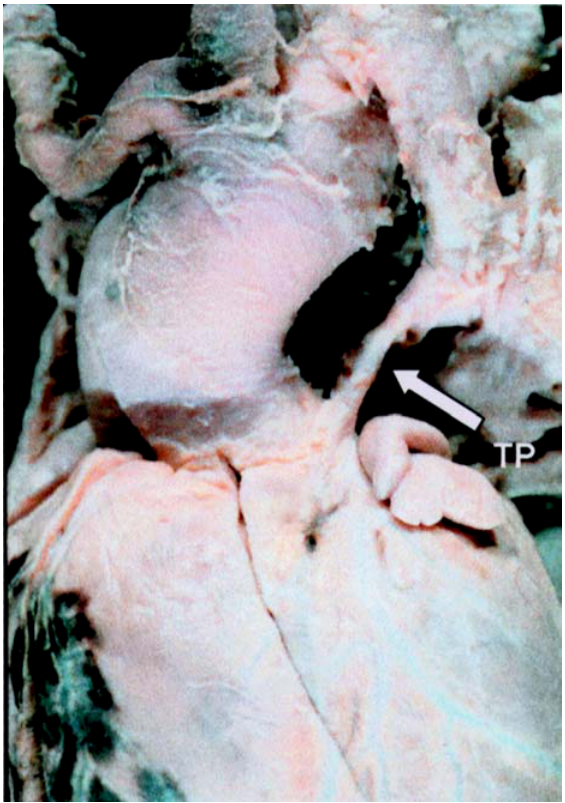
Fig. 3 – Aspecto interno da aorta descendente exibindo a origem das artérias colaterais sistêmico-pulmonares